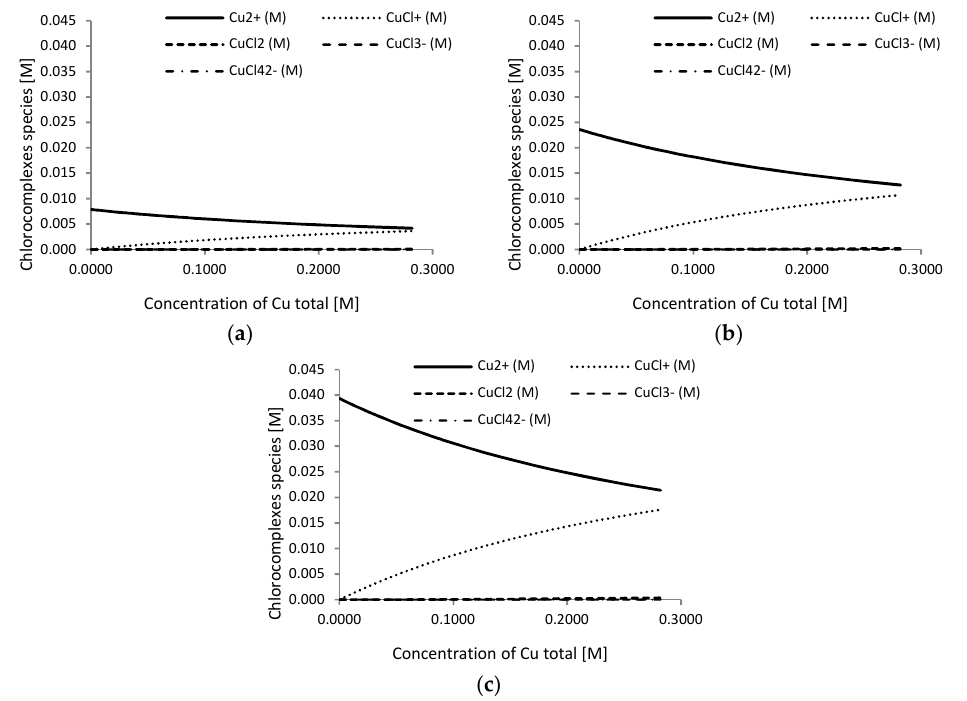
Figure 6. Predicted copper complex (M) at a chloride concentration range from 0 to 10 g L −1 , and as a function of cupric concentration: ( a ) [Cu 2+ ] = 0.5 g L −1 ; ( b ) [Cu 2+ ] = 1.5 g L −1 ; and ( c ) [Cu 2+ ] = 2.5 g L −1 .